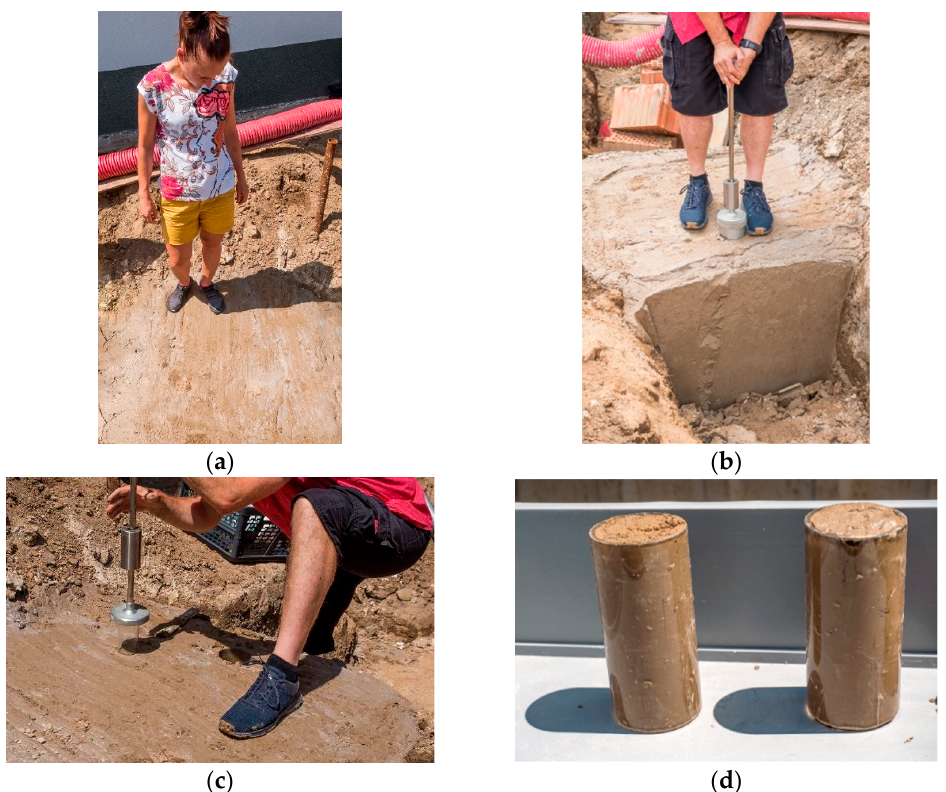
Figure 10. ( a ) Load capacity of the applied grout after three days; ( b ) sampling after three days from the implementation; ( c ) sampling after three days from the implementation; ( d ) samples taken for further